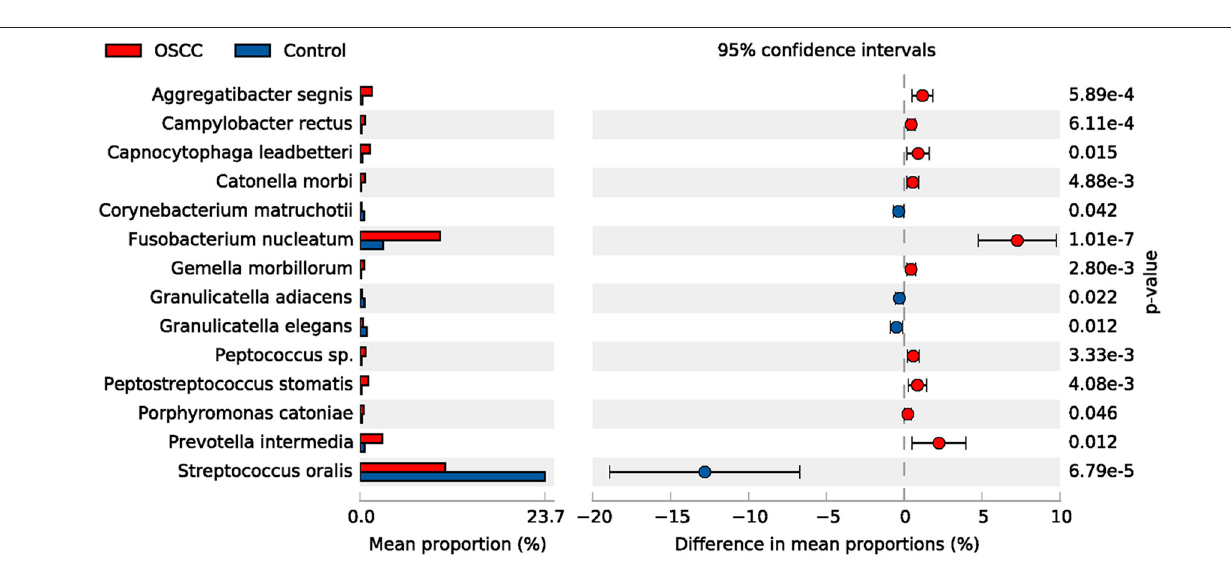
in the tumor sites (Yost et al., 2018). F. nucleatum infection is prevalent in human colorectal carcinoma (Castellarin et al., 2012), and various mechanisms are involved in the process. For